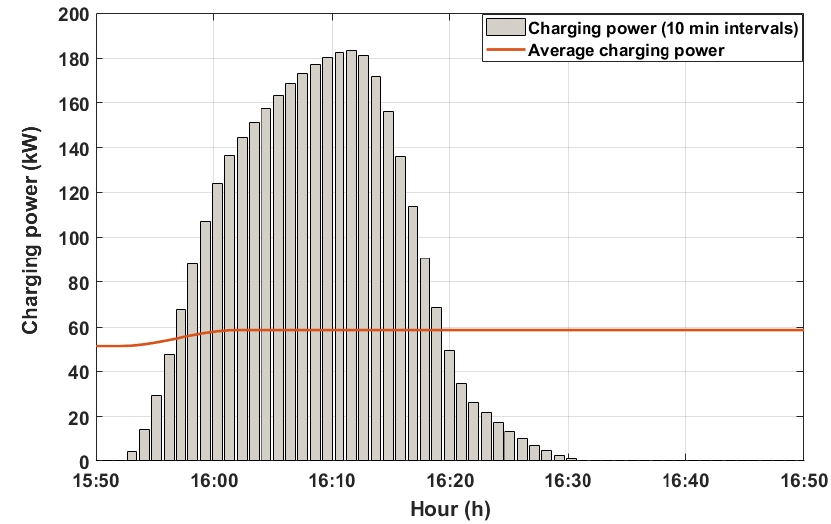
Table 6. Maximum power of bus charging on the Wilanów terminus.